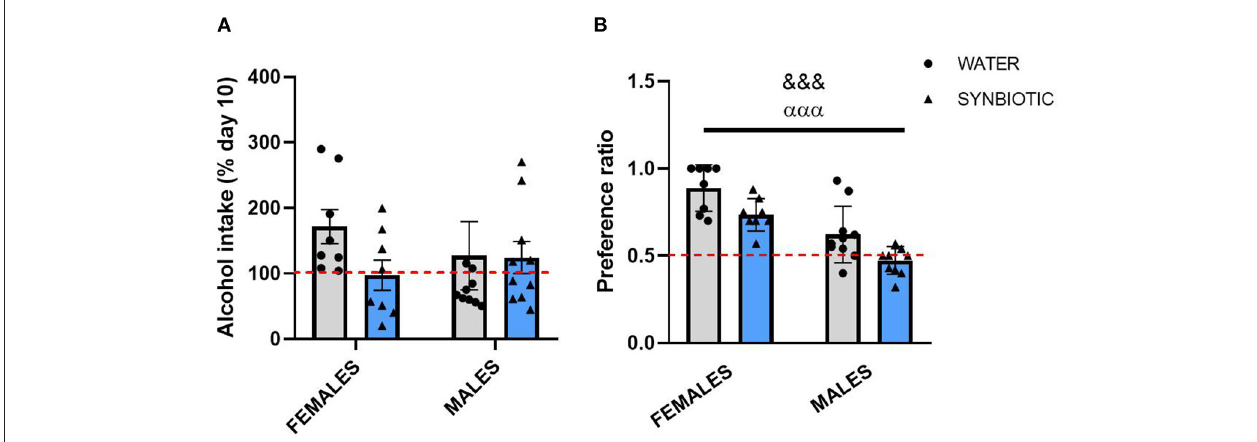
FIGURE 3 | Alcohol intake and preference after alcohol deprivation in female and male mice treated with water (gray bars and round symbols), or synbiotic (blue bars and triangular symbols). Following repeated intermittent exposure to alcohol (15% ethanol solution in water), mice were deprived of alcohol for 7 days and subsequently tested in abstinence. Alcohol intake (% of day 10) and the alcohol preference ratio were quantified during the first 4h of access. (A) For alcohol intake, no significant interaction or main effects were observed. However, females treated with water showed an increase in alcohol intake vs. day 10, but not those treated with synbiotic; and males treated with water also showed a slight increase in alcohol consumption, but this effect was similar in the synbiotic group. (B) Both females and males treated with water showed a preference for alcohol, but the preference ratio was significantly lower in males than in females. Both females and males treated with synbiotic showed less preference for alcohol than those treated with water. &&& p < 0.01 (main effect of sex); ααα p < 0.01 (main effect of treatment) two-way ANOVA.